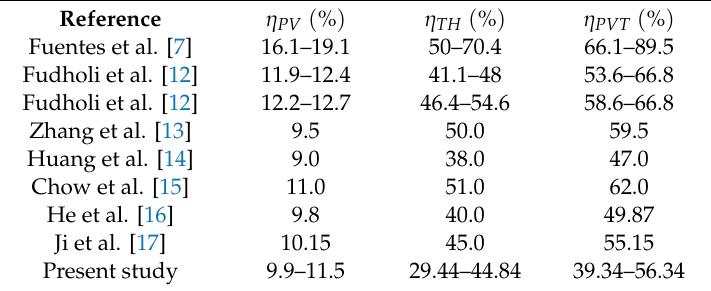
Table 4. Comparison of present study with other water based PVT e ffi ciencies.